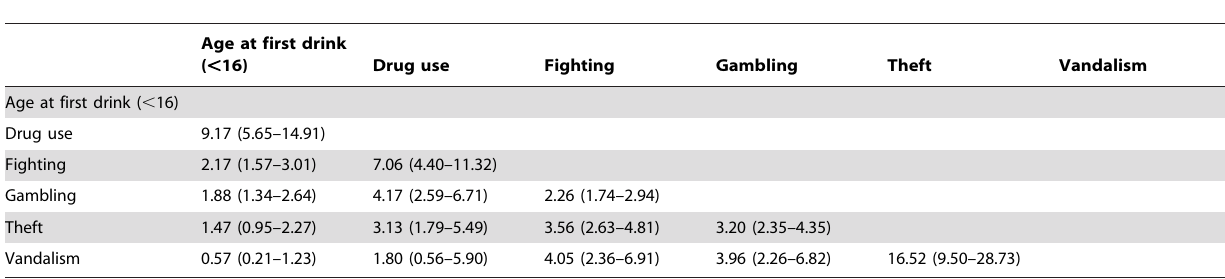
Table 2. Odds ratios and 95% confidence intervals of unadjusted associations among components of the DBS.